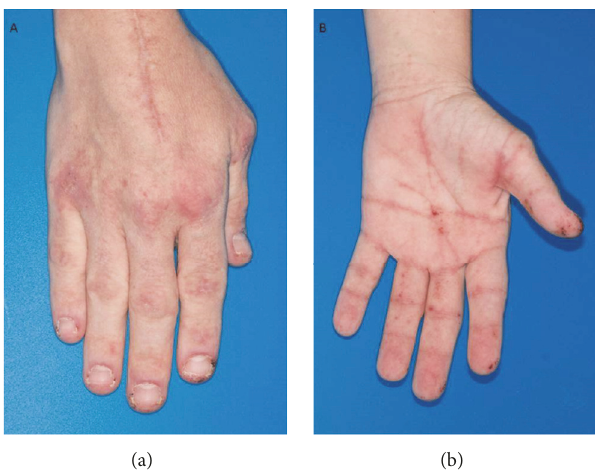
Figure 1: (a) Right dorsal hand with scaly pink plaques. (b) Left palmar surface with punctate firm hemorrhagic papules.